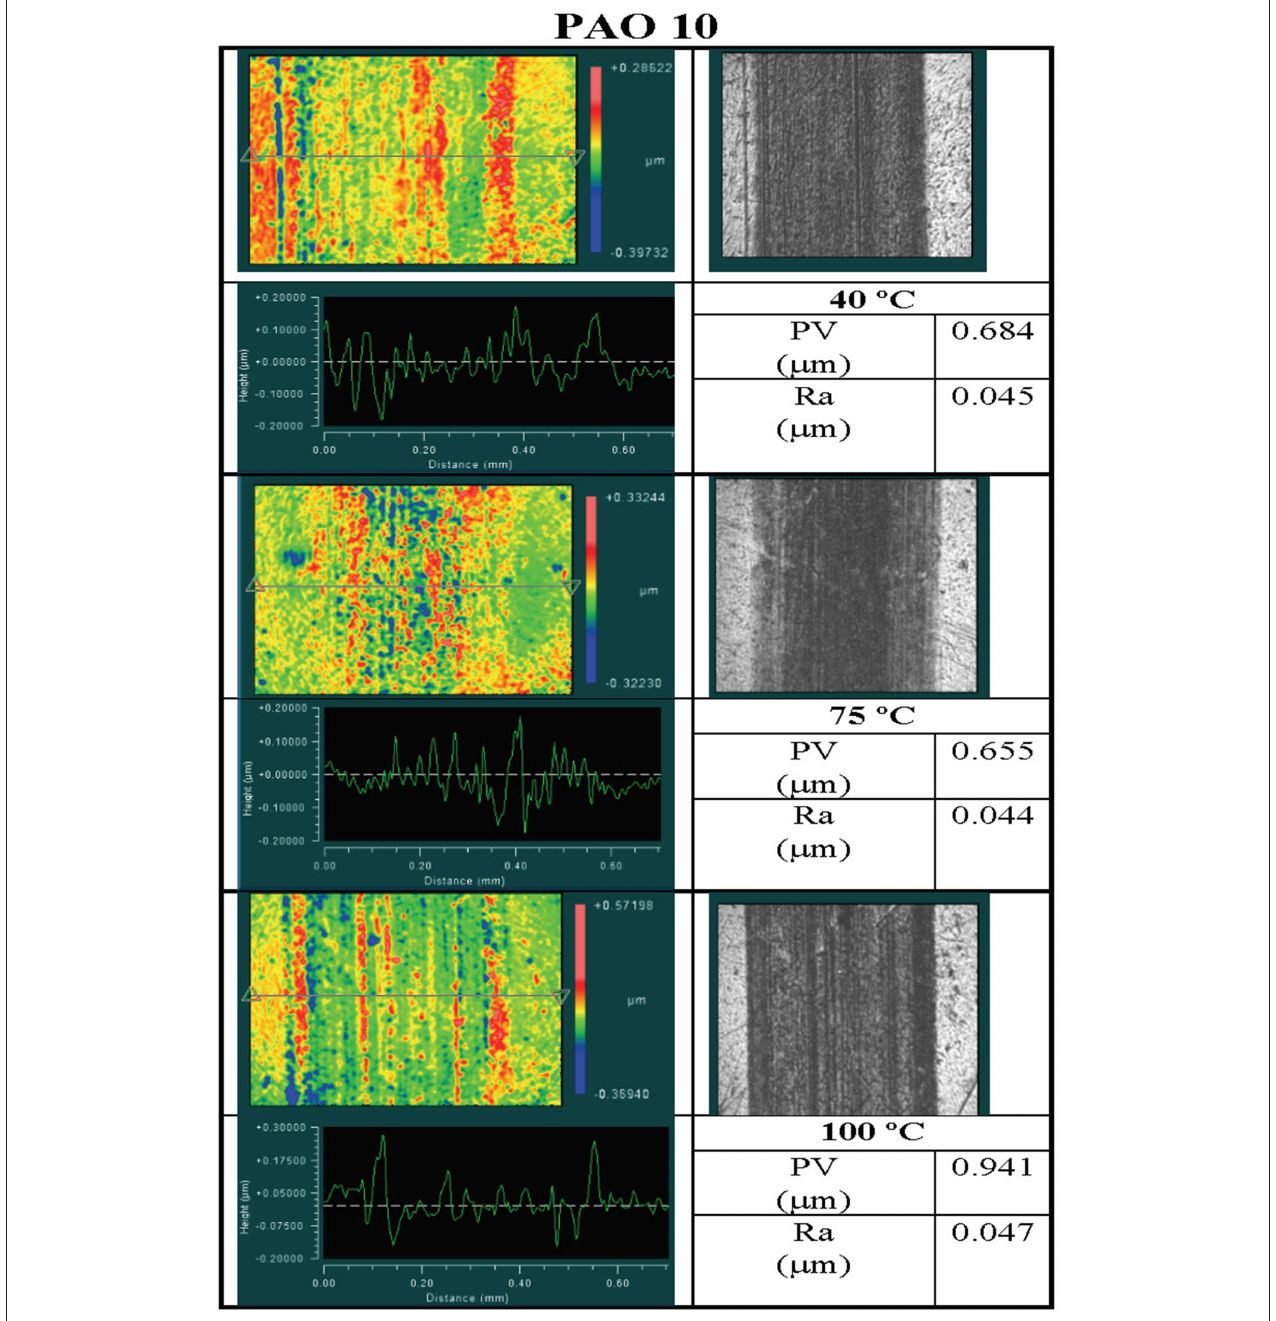
FIGURE 4 | Analysis of wear tracks formed on disks at 40 ◦ , 75 ◦ , and 100 ◦ C in tests performed with the PAO 10 oil. Clockwise in each temperature box are a false color surface map, an optical image of the wear track, the values of PV and Ra in the wear track, and a line trace across the wear track.